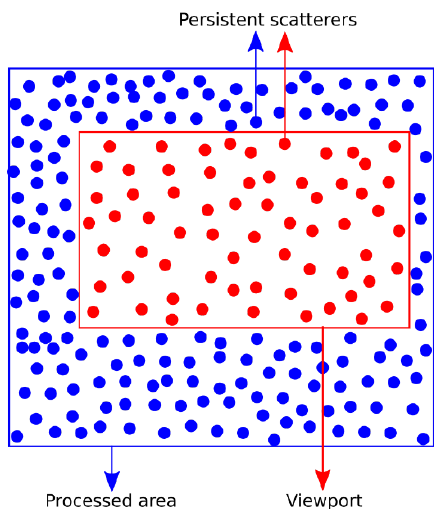
Figure 9: Selection of points inside the application’s viewport.